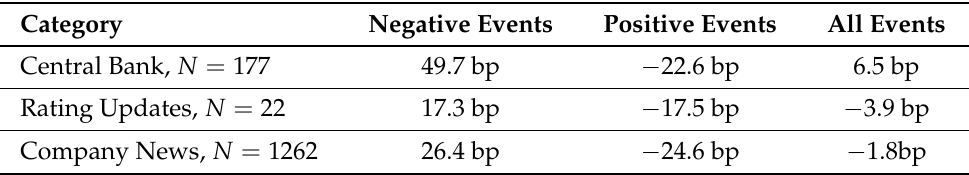
Table 2. Summary of the event study. Authors’